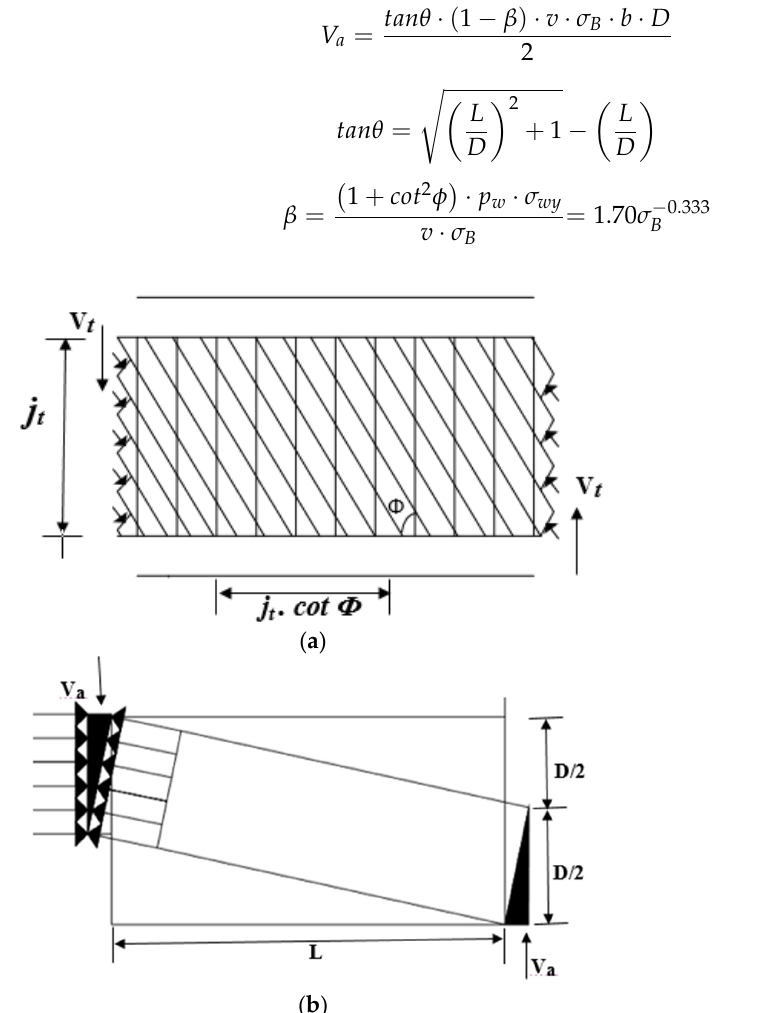
Figure 11. Truss and arch mechanisms based on the AIJ A-method: ( a ) truss mechanisms; ( b ) arch mechanisms.